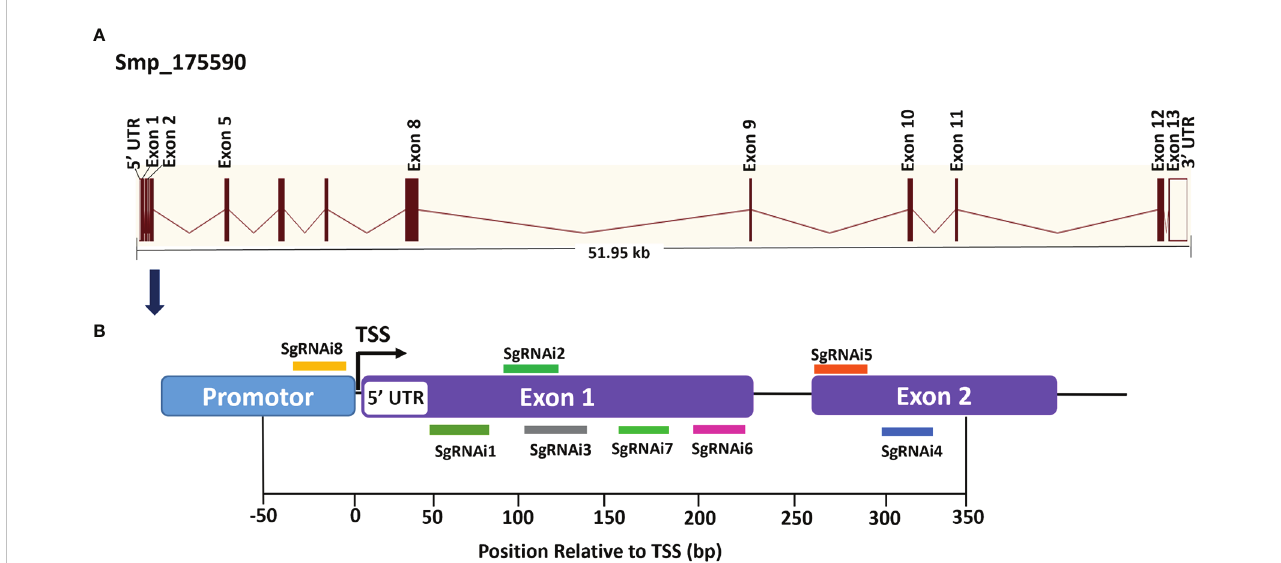
FIGURE 1 Gene structure of S. mansoni fi broblast growth factor receptor A ( SmfgfrA ) and locations of singe-guide RNAs (sgRNAs). (A) Schematic diagram of the SmfgfrA (Smp_175590) gene containing thirteen exons, twelve introns, 5 ’ untranslated region (5 ’ UTR) and 3 ’ UTR, spanning 51.95 kb on the reverse strand of S. mansoni chromosome 1. (B) Diagram of SmfgfrA indicating target sites of eight sgRNAs (i1-i8). SgRNAs (i1-i7) were designed for inhibition of transcription elongation within a window from +67 bp to +329bp relative to the transcriptional start site (TSS) of SmfgfrA . SgRNA i8 aligns to the promotor region (-21 bp to -2 bp) of SmfgfrA